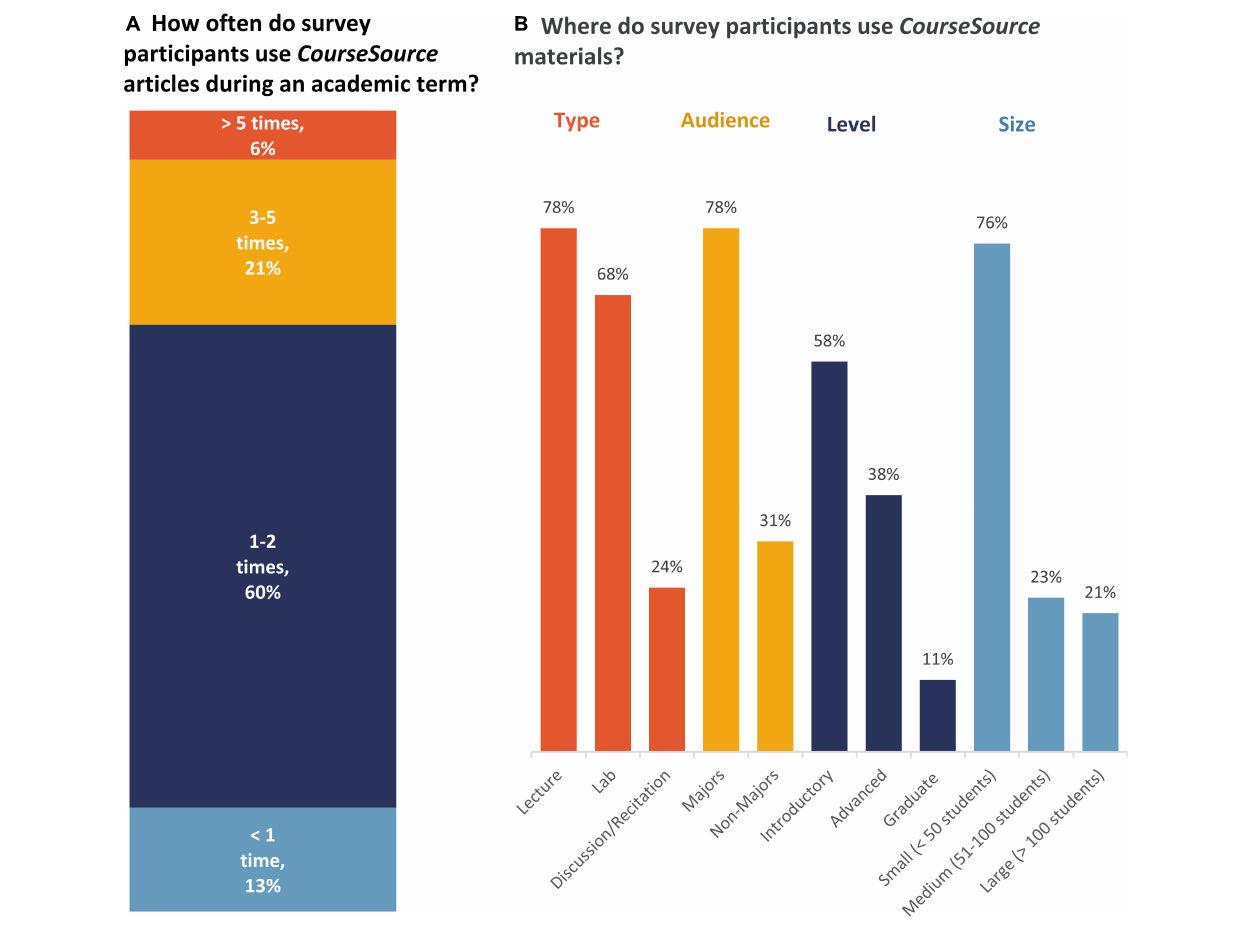
FIGURE 7 | Survey participants’ Use of CourseSource . Captures (A) the number of times survey participants use CourseSource during an academic term and (B) types of courses for which survey participants use